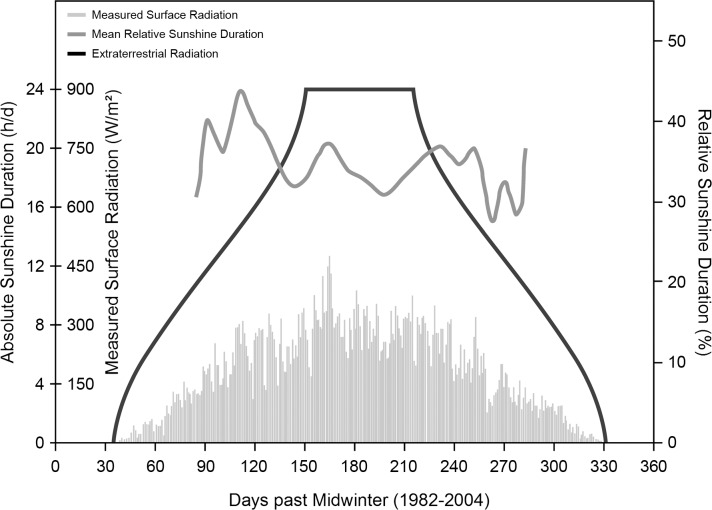
Duration of sunshine at the Neumayer Stations in Antarctica (1982–2004).Plots of extraterrestrial radiation (black), relative sunshine duration (dark grey) and measured surface radiation (light grey) at the location of the Neumayer Stations. The x-axis displays the time in days with “0” representing midwinter (June 21st). For a period of about 100 to 120 days around midwinter virtually no light reached the surface. (Unpublished personal communication in 2012 by G. König-Langlo, “Alfred Wegener Institute for Polar and Marine Research”, Bremerhaven).